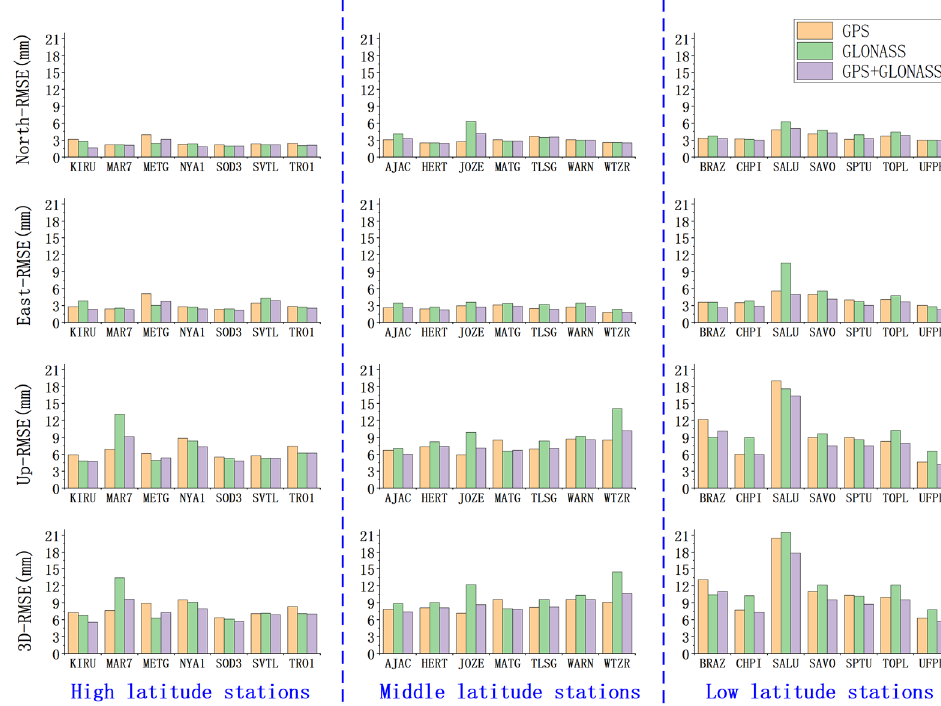
Figure 13. The RMSE of coordinates of all the stations estimated with PPP.